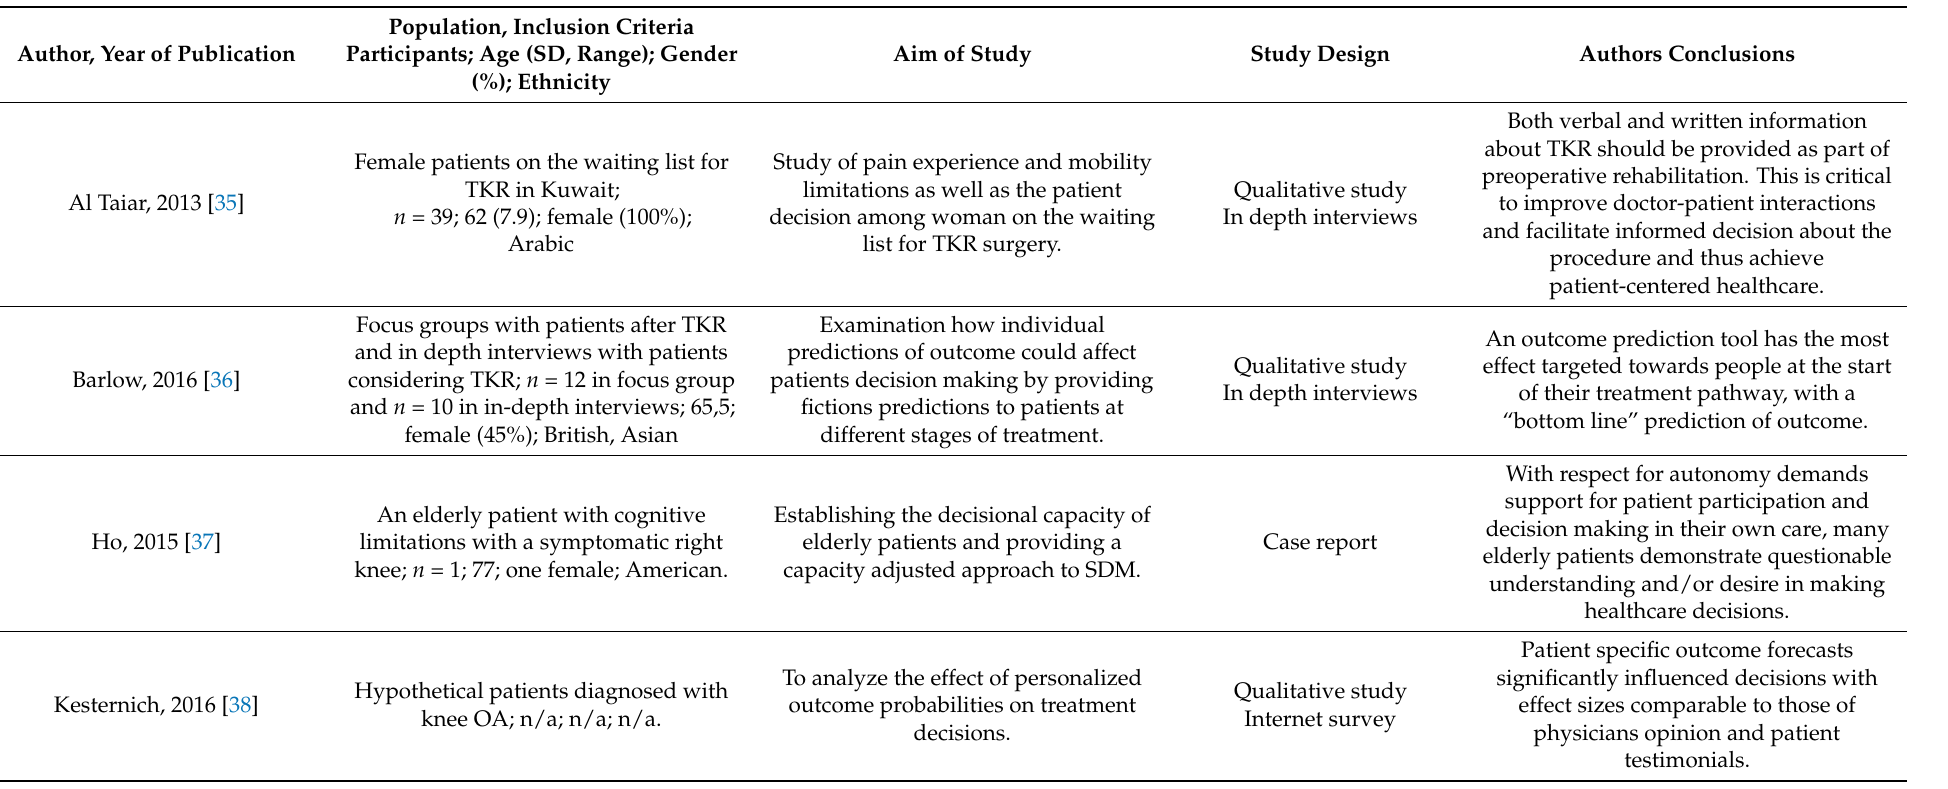
Table 1. Characteristics of the included manuscript to determine which factors support the decisional skills and / or capacity of patients considering, choosing, preparing and/or recovering from total knee replacement (TKR)